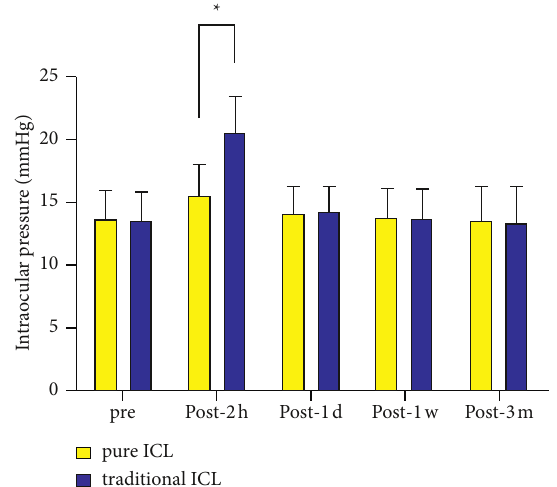
Figure 2: Time course of IOP changes in eyes undergoing pure ICL implantation and traditional ICL implantation. ∗ P < 0 . 001.